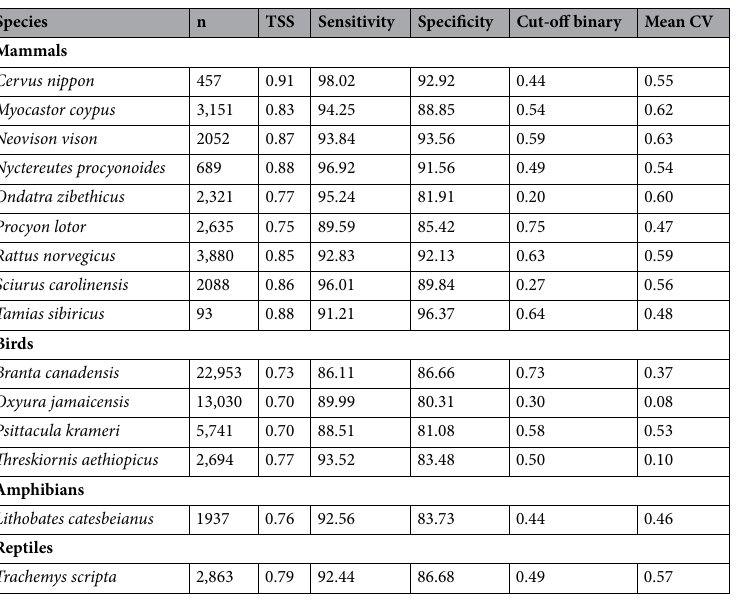
Table 3. Results on the predictive ability of the global models using the certain + NA dataset. n indicates the number of presence points used to fit the model. TSS is the true skill statistic. Sensitivity is the proportion of positives correctly predicted. Specificity is the proportion of absences correctly predicted. Cut-off binary shows the value of suitability (0–1) that maximized the sum of sensitivity and specificity (TSS) and was used to convert the continuous prediction into binary. Mean CV is the mean coefficient of variation among models in the ensemble prediction standardized between 0 and 1.